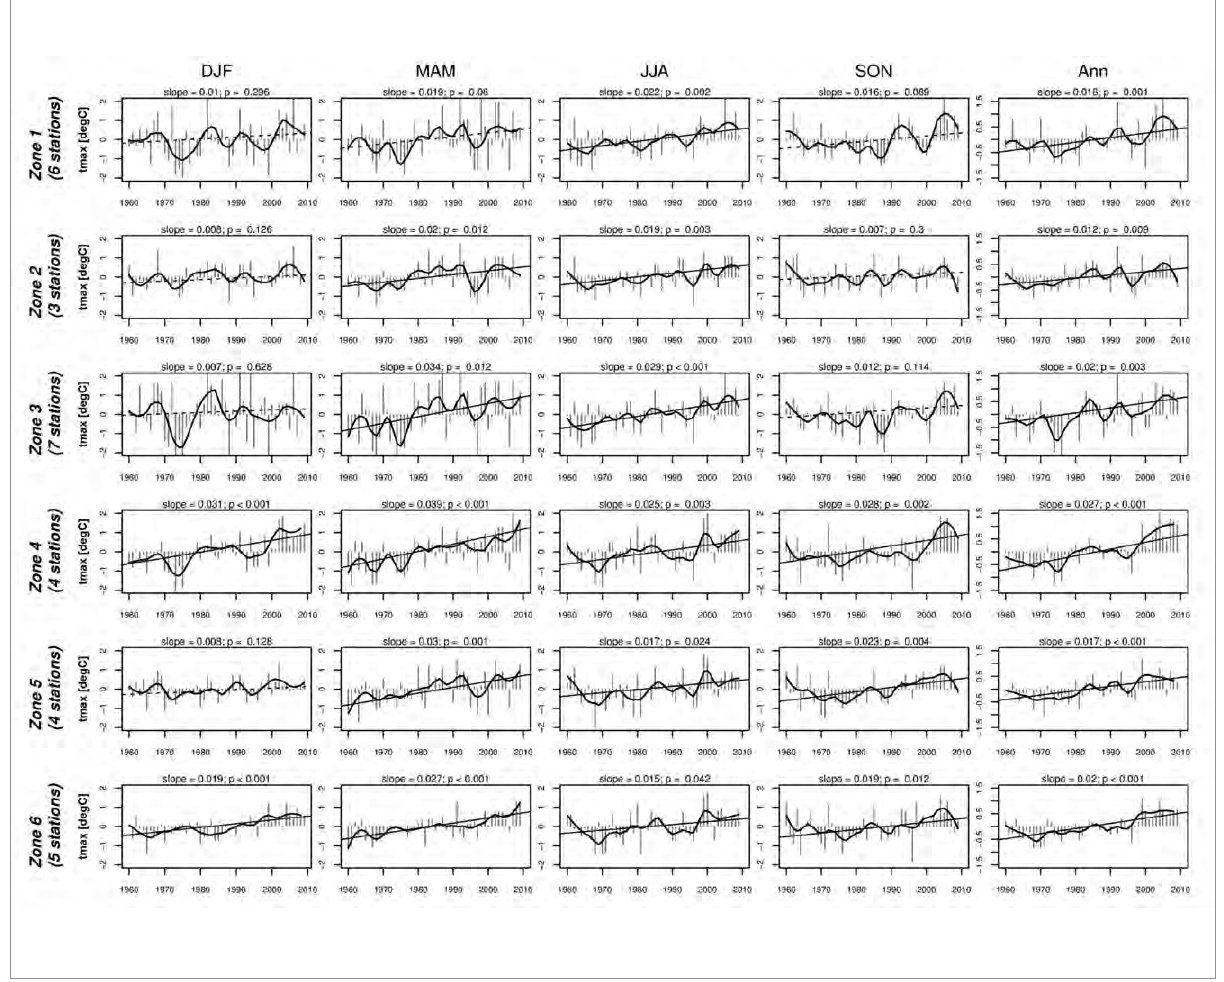
Figure 7: Regional mean time series and trends in mean daily maximum temperature (tmax, °C) for stations in the six water management zones for summer (DJF), autumn (MAM), winter (JJA), spring (SON) and annual (Ann) means. Grey bars represent departures from the 1960–2010 mean for each year. Black curves are a Loess smoothing of the yearly data with a bandwidth of 0.25. Trend lines are shown for the Sen’s slope estimate. Solid trend lines indicate the trend is significant at the 5% level and dashed lines are not significant at this